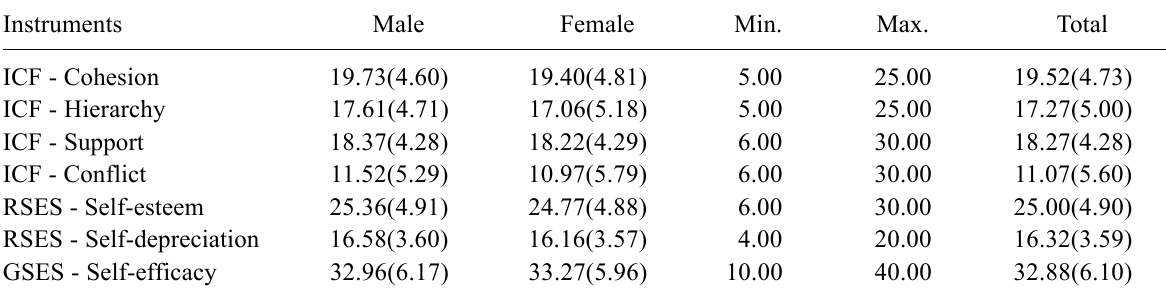
Means and Standard Deviations of Ratings on the ICF, RSES and GSES (N=656) Instruments